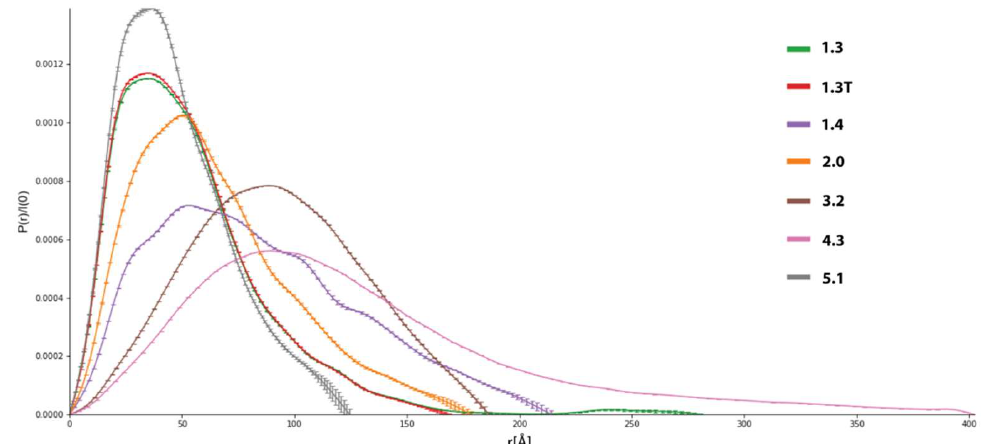
Figure 6. P ( r ) functions for selected datasets extracted from initial SEC-SAXS data. All these datasets were selected for further analysis.